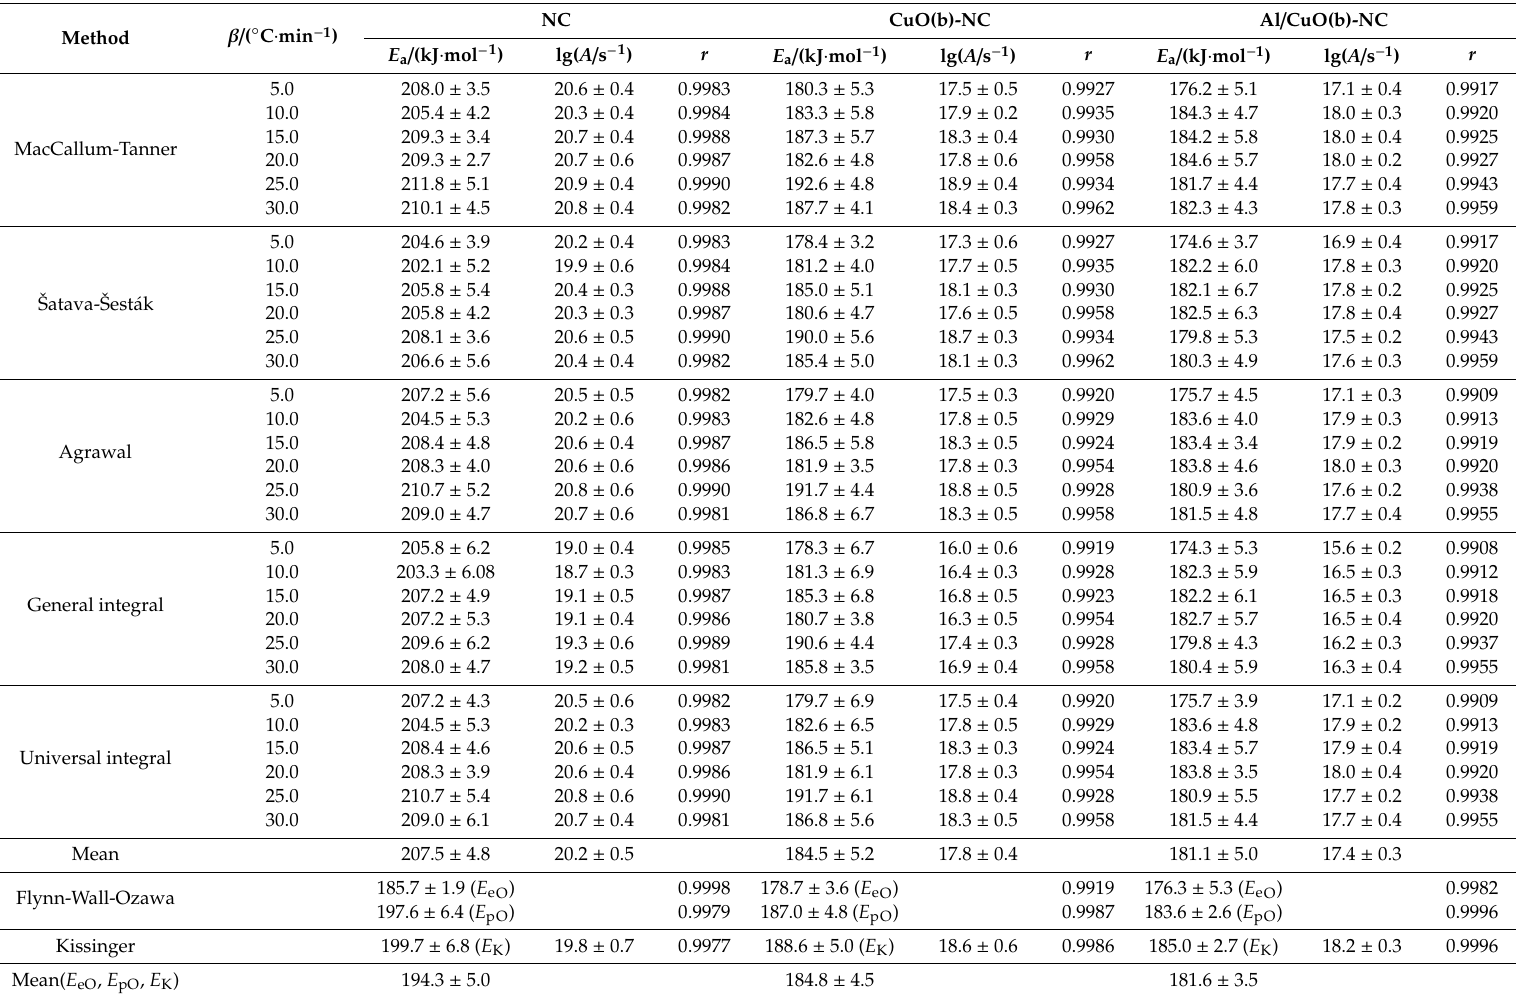
Table 1. Calculated values of kinetic parameters of decomposition reaction for NC, bamboo leaf-like CuO(b)-NC, and Al /